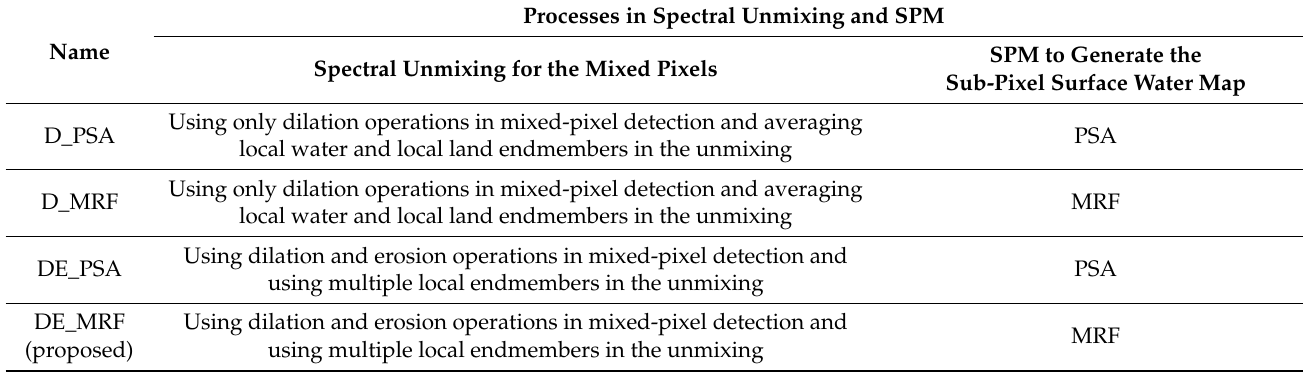
Table 1. Explanation of different sub-pixel mapping